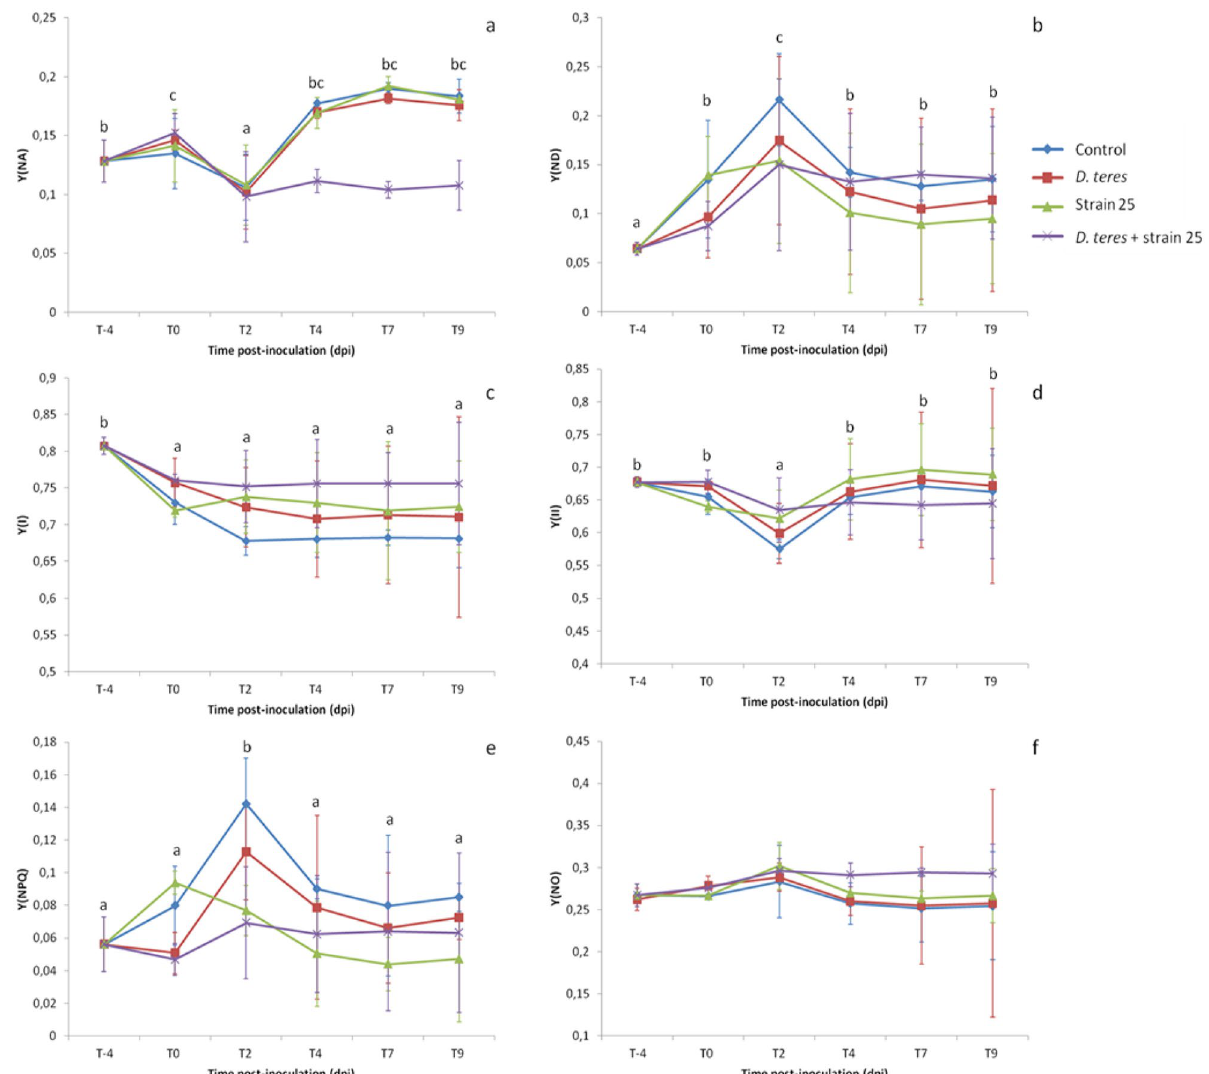
Figure 3. Variations of PSI parameters with PSI acceptor side limitation Y(NA), PSI donor side limitation Y(ND) and efficient quantum yield of PSI Y(I) in barley leaf accompanied by changes of PSII parameters with quantum yield of regulated energy dissipation Y(NPQ), quantum yield of non-regulated energy dissipation Y(NO) and efficient quantum yield of PSII Y(II). The measurements were performed with several experimental conditions: control barley, barley infected with D. teres , barley bacterized with strain B25 and barley infected with D. teres in combination with strain B25. These data were obtained 4 days before inoculation with D. teres (T-4), 0 days before (T0 BP) or after pulverization of the pathogen (T0 AP), 2, 4, 7 and 9 dpi with D. teres noted T2, T4, T7 and T9, respectively. The mean was calculated from three independent experiments for each experimental condition and for each time-point, n = 15. Different letters indicate statistically different means (Student’s test; p value < 0.05) between times plants decreased Y(NPQ) compared to the control barley plants which maintained higher values. However, this mechanism is regulated by the dissipation of excessive excitation energy into harmless heat allowing protect plant. Indeed, Y(NPQ) indicated the regulated thermal energy dissipation. Therefore, Y(NPQ) could be stimulated by the xanthophylls cycle if excitation energy is in excess. Without this energy dissipation, singlet O2 and other reactive oxygen species could be formed and therefore, allowed an increase of Y(NO) parameter 58 . In this way, the alterations caused by the pathogen probably reflect the inability of the barley to regulate it mechanisms of photoprotection, resulting in photooxidative damage to the infected host tissue. This regulation was less imple- mented in the presence of strain B25. Therefore, this result suggested that bacterized-plant implemented less photoprotection mechanisms and did not stimulate the xanthophylls cycle. This result with strain B25 could be explained by the fact that the reaction centers in the thylakoid membrane were open, which led to less activity of NPQ process to compared to the ones closed in control barley 64,65 .